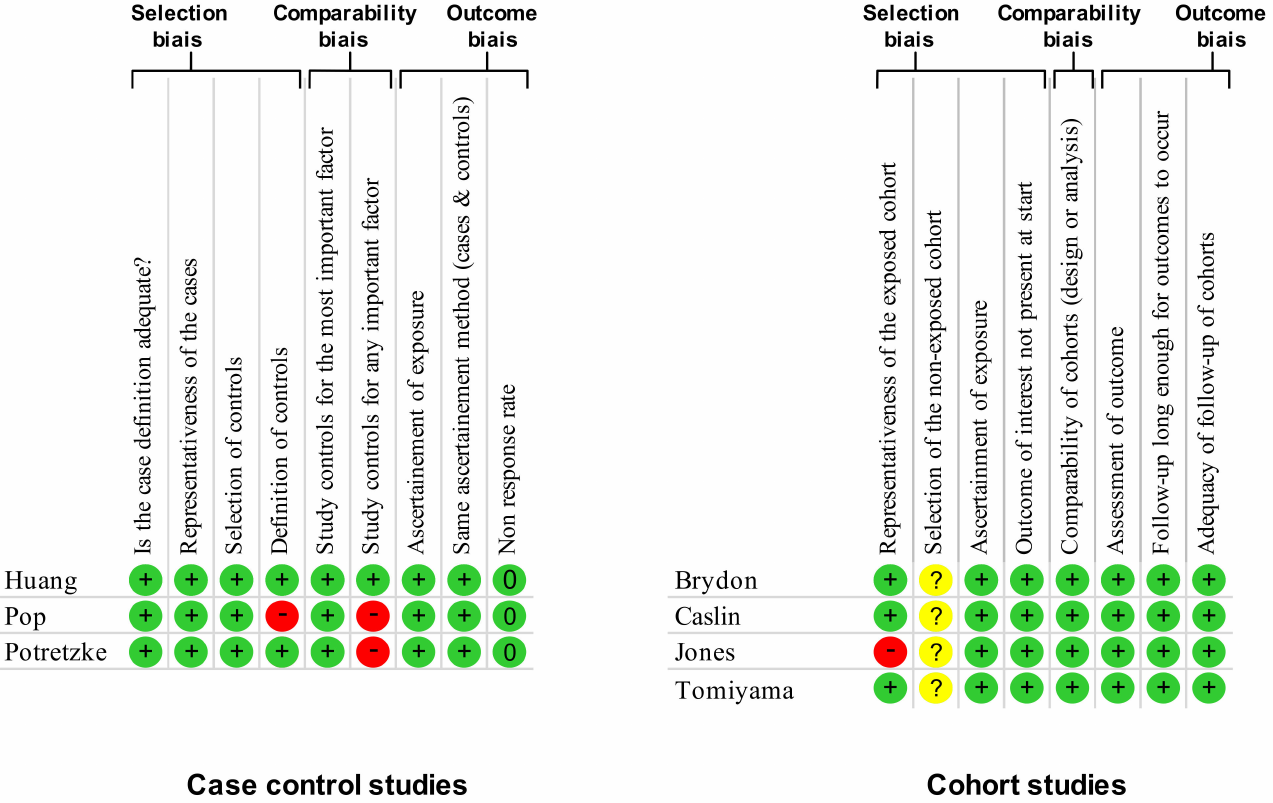
Figure 2. Methodological quality of included articles using Newcastle—Ottawa Quality Assessment Scale Yes, +; No, − ; Cannot say, ?; Not applicable, N/A; 0, percentage of